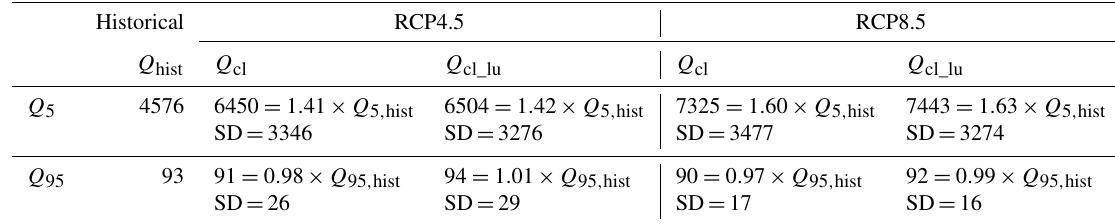
Figure 5. Six-year CFs of precipitation in the Upper Ganges basin. Each dot represents the basin’s areal average of a particular model. The precipitation anomalies are relative, unitless values. A higher than 1 value indicates an increase and a smaller than 1 value indicates a decrease in precipitation. The blue line represents the mean value whereas the shading represents the spread of projections from the multi-model ensemble. Table 2. Q 5 and Q 95 flow values (m 3 s − 1 ) based on the flow duration curves shown in Fig.